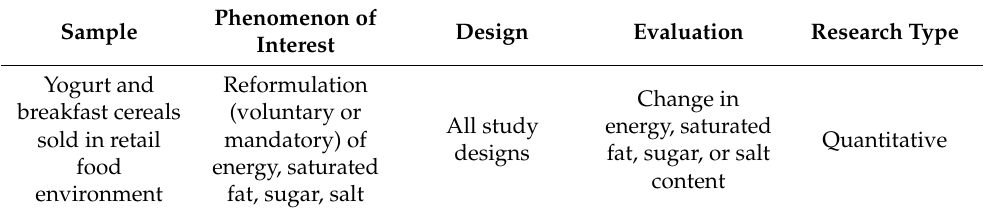
Table 1. SPIDER (Sample, Phenomenon of Interest, Design, Evaluation and Research Type) table for the selection of studies. Phenomenon of Design Evaluation Research Sample Interest